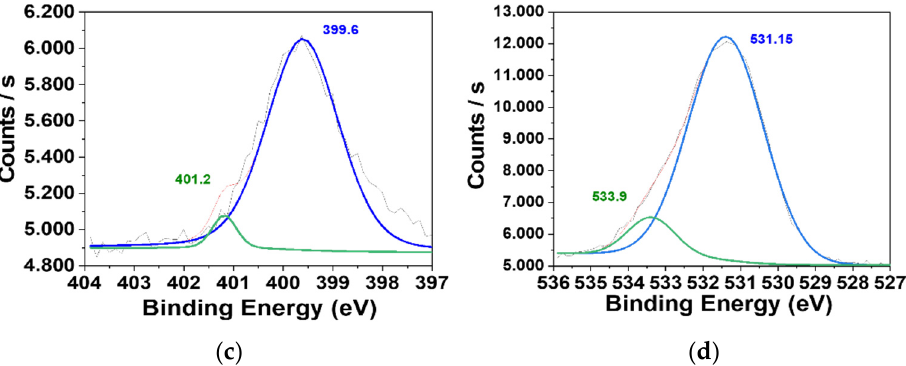
Figure 2. XPS core ( a ) C 1s level spectra for CD F and ( b ) CD 0 , and ( c ) N 1s and ( d ) O 1s level spectra for CD F .